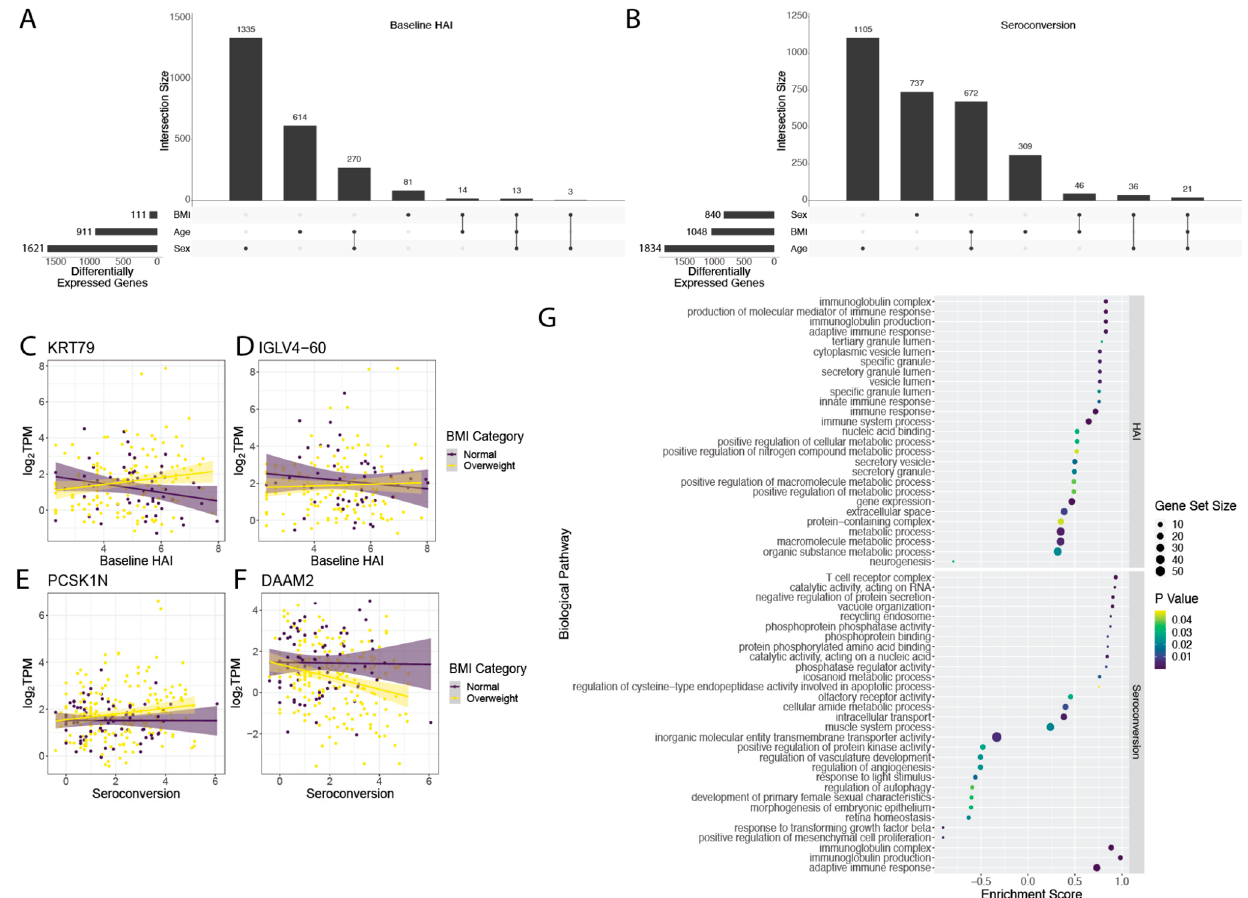
Figure 3. Interactive effects of physiological variables on differential expression with baseline HAI and seroconversion. Sets of genes showing interactive effects with sex, BMI and age on differential gene expression with ( A ) baseline HAI and ( B ) seroconversion. Representative genes in which BMI impacts ( C ) positive and ( D ) negative differential expression with baseline HAI. Representative genes in which BMI impacts ( E ) positive and ( F ) negative differential expression with seroconversion. ( G ) Gene function enrichment using GSEA of 111 genes that show interactive effects with BMI and baseline HAI ( top ) and 1048 genes that show interactive effects with BMI and seroconversion ( bottom